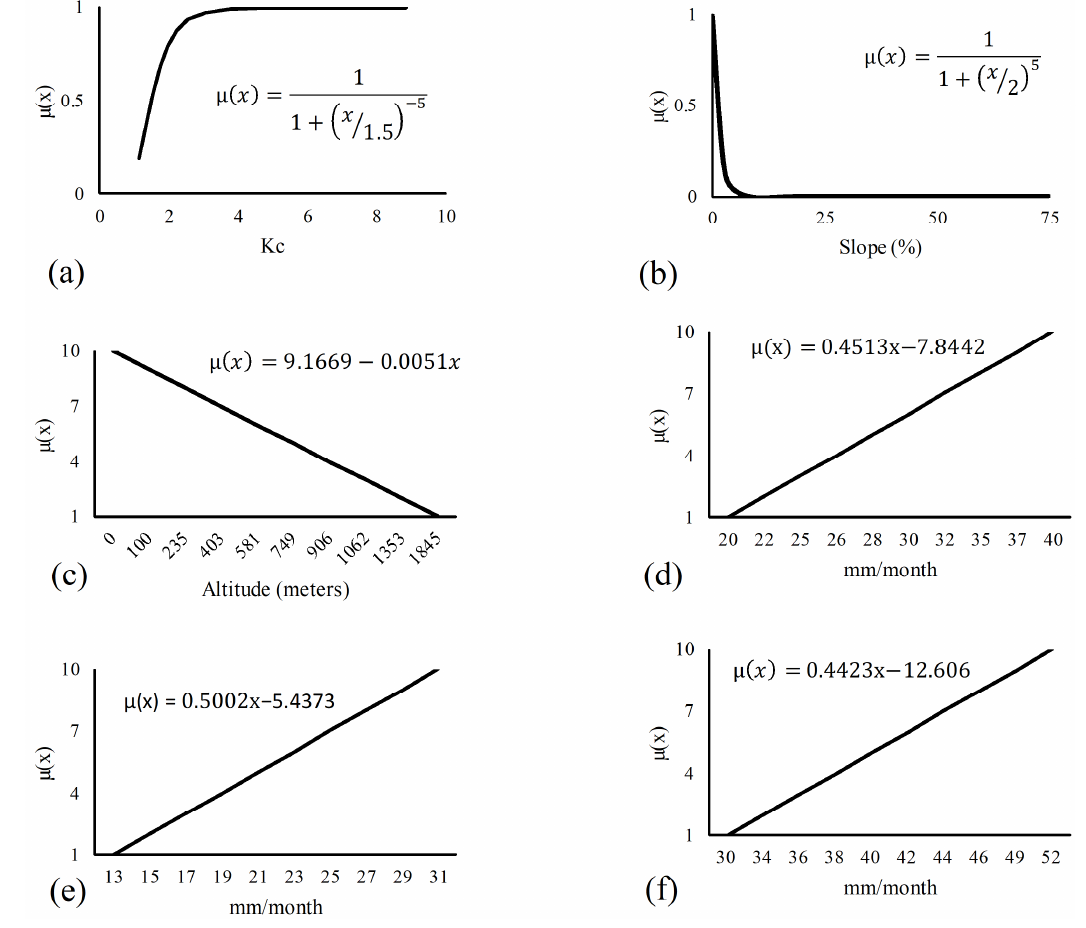
Figure 3. Membership functions applied to the flood vulnerability model variables. ( a ) Compactness coefficient; ( b ) slope; ( c ) Digital Elevation Model (DEM); ( d ) annual average maximum rainfall; ( e ) dry period average maximum rainfall; ( f ) rainy period average maximum rainfall.